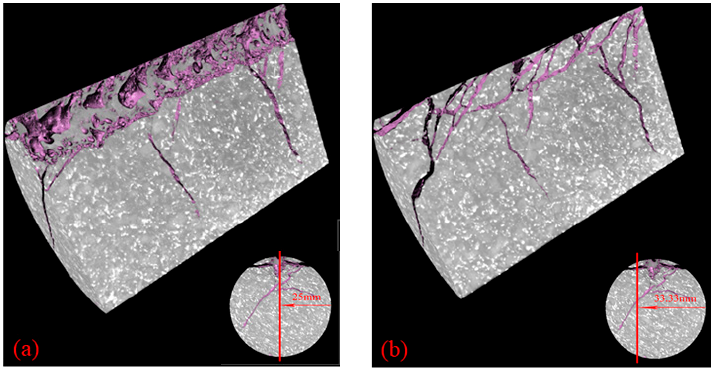
14 of 17 Figure 11. Rendered images of irradiated specimens from ( a ) front, ( b ) top and ( c ) right views. The distribution of cracks within the irradiated specimen can be illustrated further from the vertical-section view of the specimen at different locations, as shown in Figure 12. From the vertical section through the axis presented in Figure 12a, we can clearly see